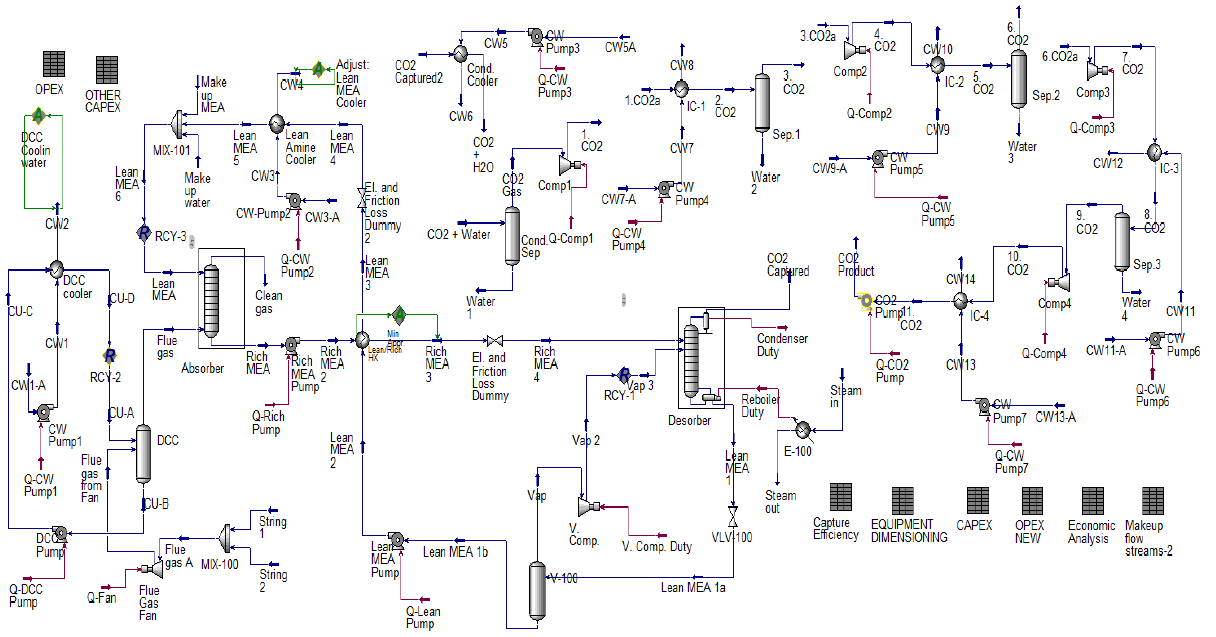
Figure A4. Aspen HYSYS simulations process flow diagram of the cement plant LVC CO 2 capture process.